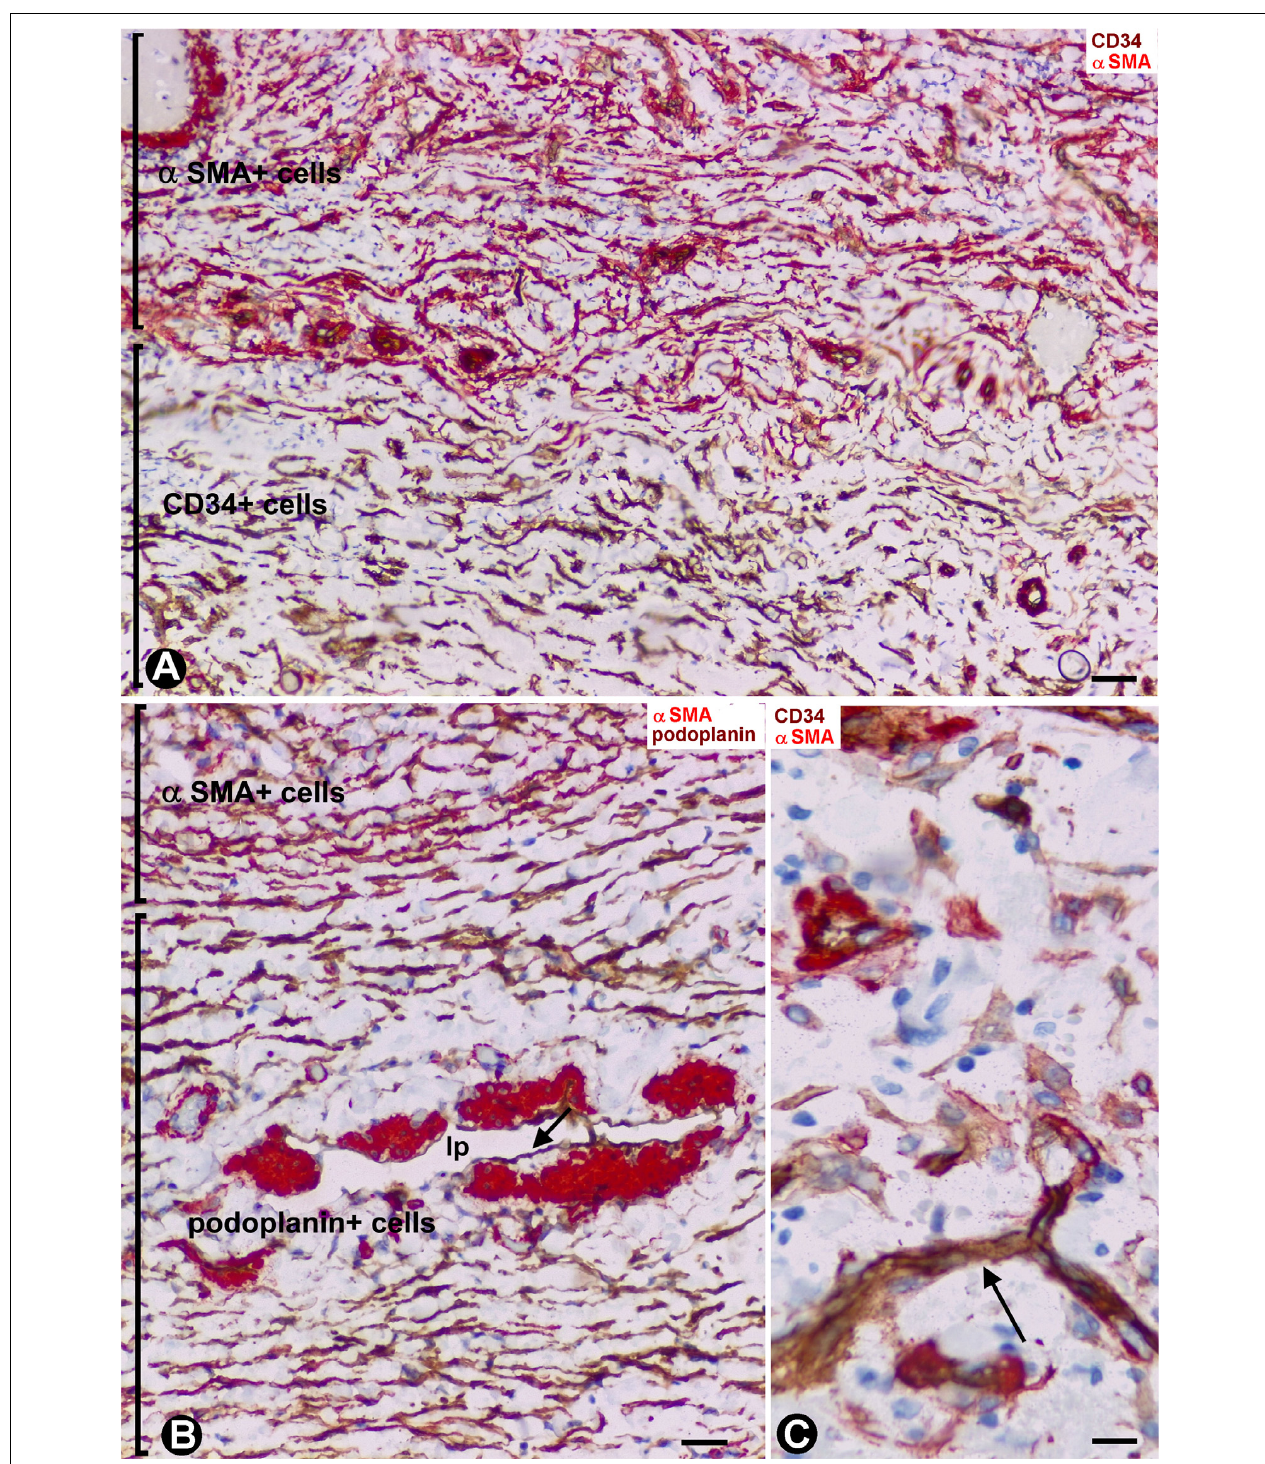
FIGURE 3 | Stromal cells during repair in acute cholecystitis. (A,C) Double staining with anti-CD34 (brown) and anti- α SMA (red). (B) Double staining with anti- α SMA and anti-podoplanin. (A) α SMA+ activated stromal cells (myofibroblastic phenotype, red) observed in the perimuscular subserosal layer, alternating with a subjacent band of CD34+ activated stromal cells (brown). (B) α SMA activated stromal cells of a strand of the serosal layer are observed alternating with a band of podoplanin+ cells, which also express CD34 (not shown). Note the presence of a lymphatic pre-collector vessel (LpV) with podoplanin+ endothelial cells (arrow) and groups of SMCs (red) in its wall. (C) Cells expressing CD34 (brown) and α SMA (red). A capillary is also observed (arrow) Bar: (A,B) 40 µ m; (C) 10 µ m.